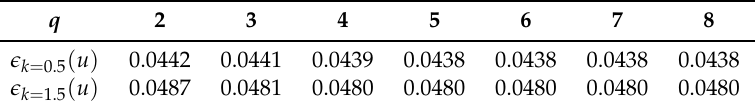
Table 1. k = 0.5,1.5, γ = 3, ε = 0.01, the errors for different q .